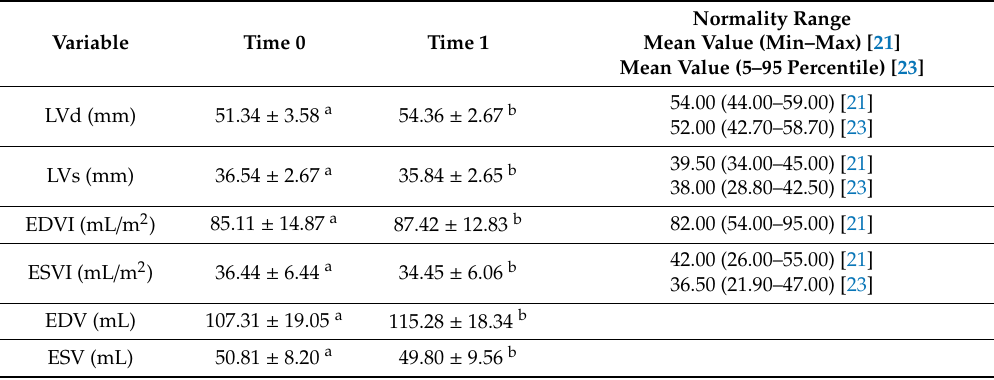
Table 2. Morphological parameters changing along pregnancy, expressed as mean ± SD at T0 and T1. The last column reports echocardiographic reference ranges of normality in Great Danes for each parameter considered (Koch et al. [21]; Stephenson et al. [23]).